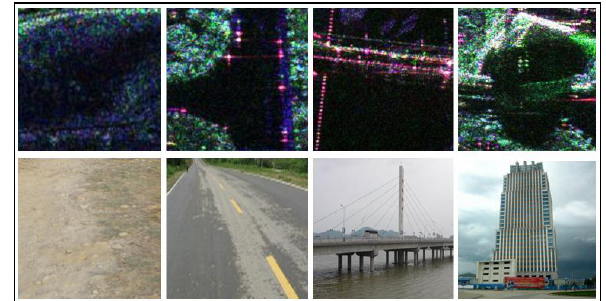
Figure 1. The typical low backscattering objects: from left to right, the bare soil, cement roads, the water and the shadow. Two reasons cause the indistinguishable phenomenon. Firstly, the low- and high-order statistical characteristics, such the backscattering cross-section (RCS) and polarimetric covariance matrix, need large look numbers to reduce the speckle. But, roads and soils usually present a narrow geographical distribution. The boxcar neighbourhood always arouses the spatial resolution loss. Furthermore, because of absenting the obvious texture, the recently popular spherically invariance random vectors (SIRV) algorithm does not represent much improvement than boxcar estimator (Hondt, O. D., 2007; Vasible, G., 2010; Formont, P., 2010). Secondly, the incident angle causes a weak backscattering power while the specular reflection